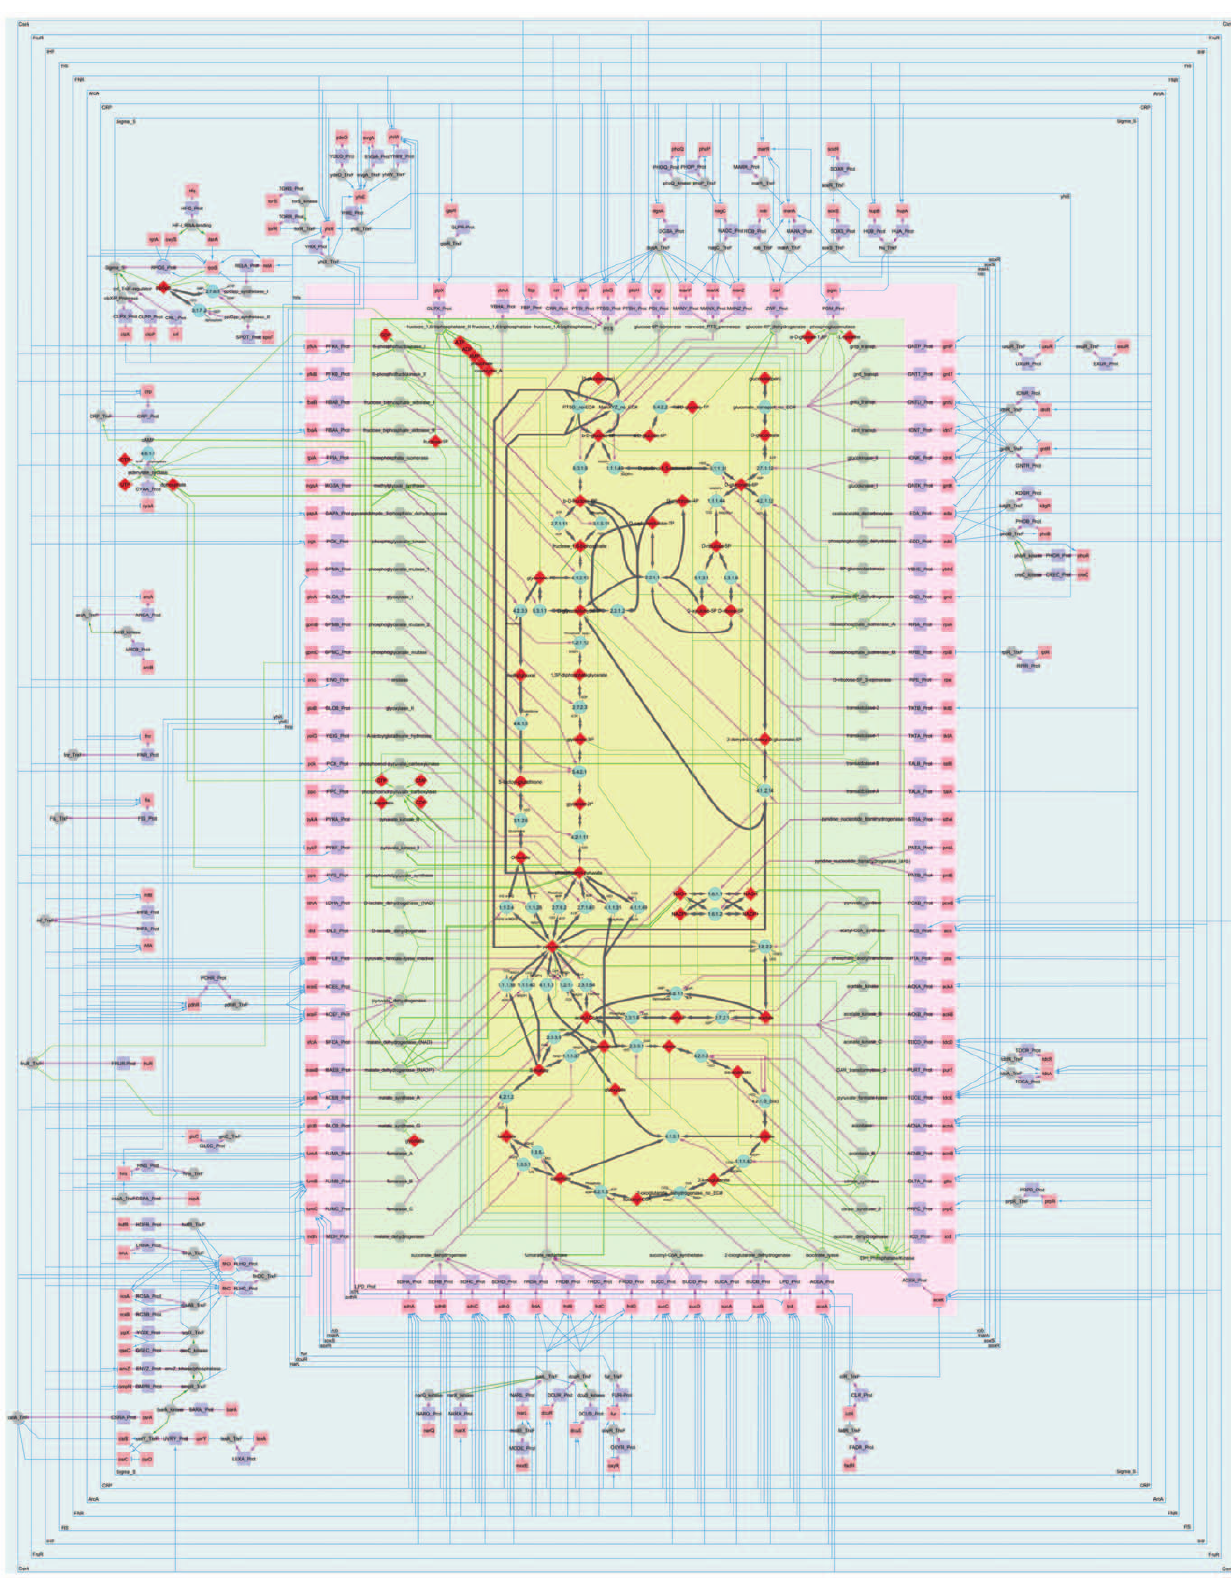
Figure 2. E . coli central carbon metabolism pathways and its regulations. The central part of the figure represents the central carbon metabolism (yellow background), with glucose entry (central topmost part) and gluconate entry (right topmost part), methylglyoxal pathway (leftmost central part), glycolysis/gluconeogenesis (left central part), Entner-Doudoroff pathway (rightmost central part), pentose phosphate pathway (right top part), TCA cycle with glyoxylate shunt (bottommost part), acetate metabolism (right bottom part) and transhydrogenase reactions (right